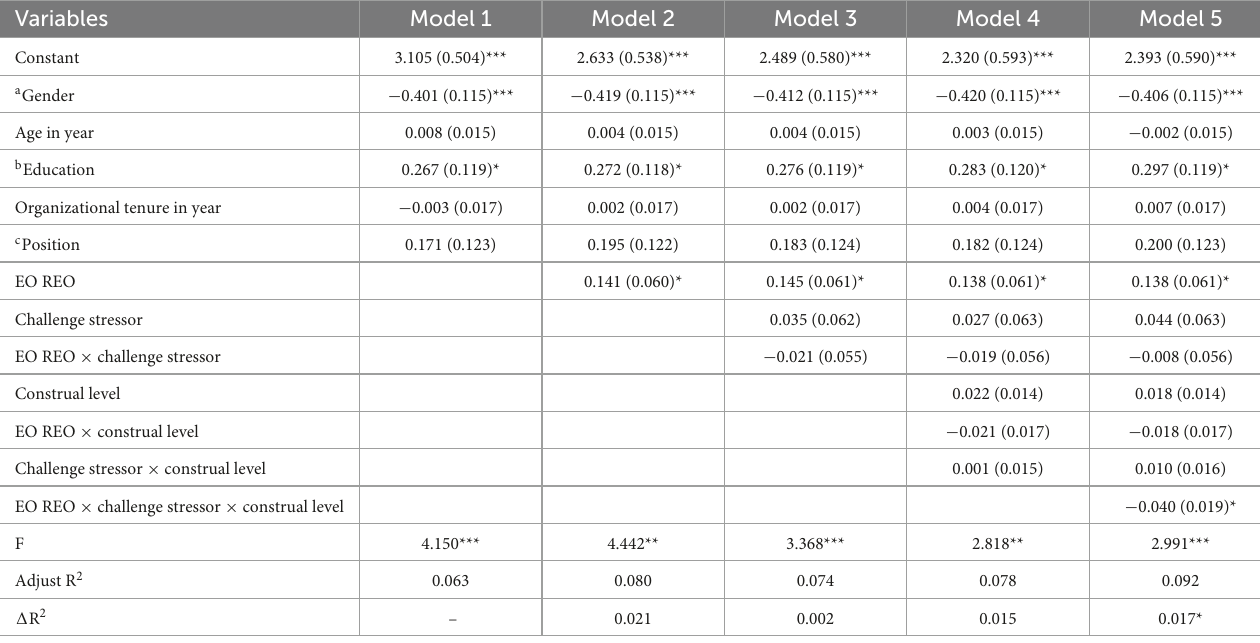
TABLE 2 The results of hierarchical regression in study